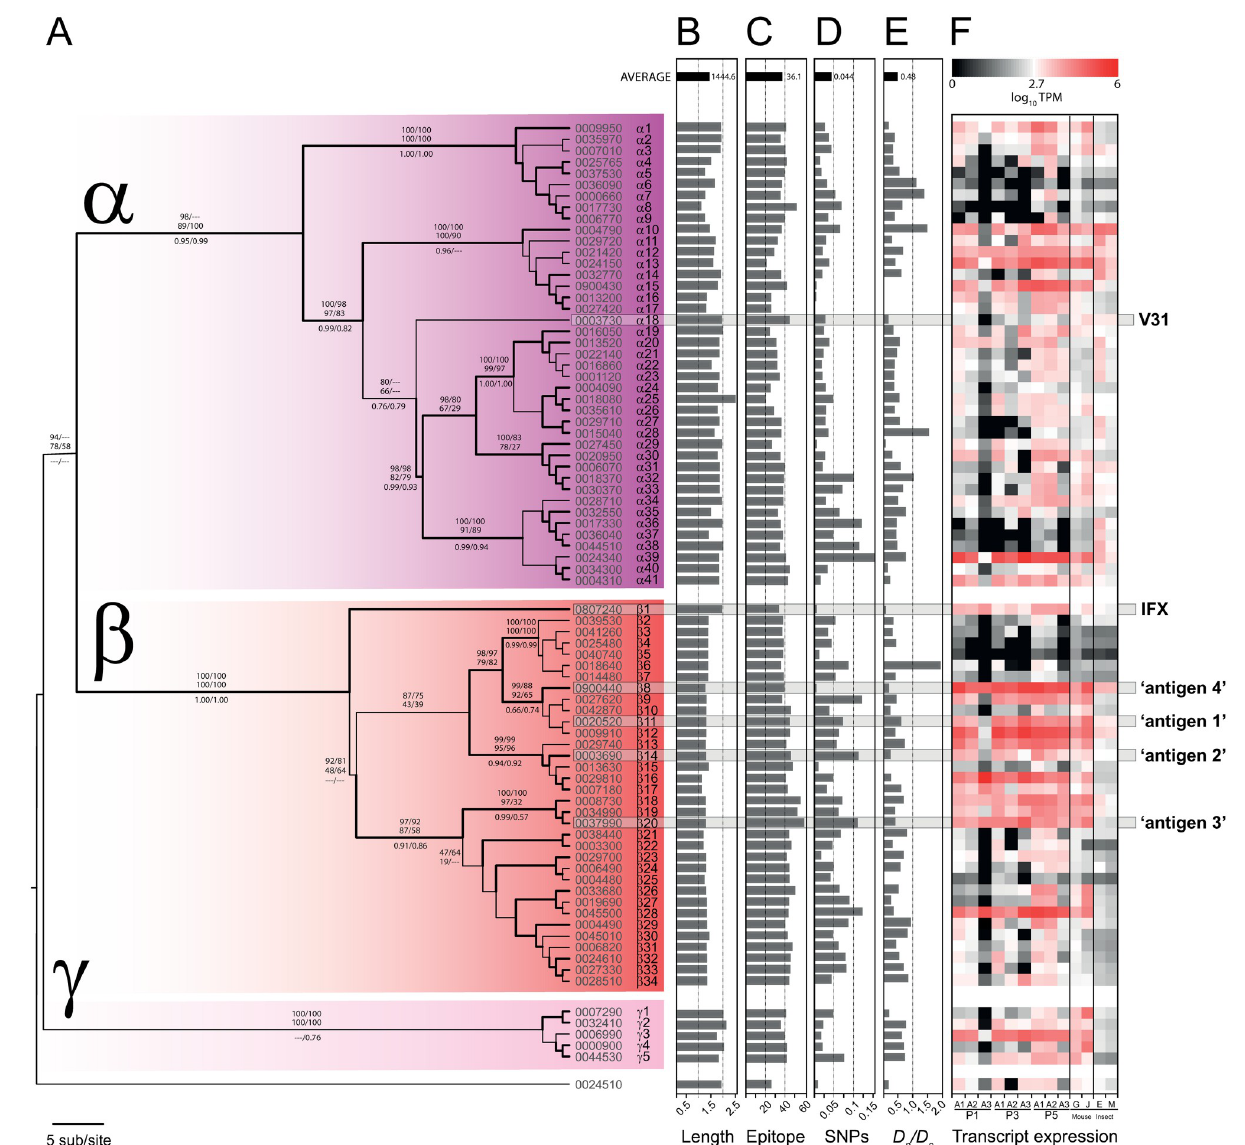
Fig 2. Vivaxin gene family phylogeny and molecular evolution. (A) Maximum likelihood phylogeny of vivaxin genes (n = 81) in the T . vivax Y486 reference genome estimated with a GTR + Γ substitution model ( α = 3.677), and divided into three principal sub-families, labelled α , β and γ . The tree is rooted with a divergent sequence (TvY486_0024510) that approximates to the mid-point. Topological robustness is measured by the approximate log-likelihood ratio (aLRT), and indicated by branch thickness. Thick branches subtend nodes with aLRT values > 0.9. Robustness measures are given for major internal nodes: maximum likelihood bootstrap values ( > 75) for nucleotide/protein alignments (upper, above branches), neighbour-joining bootstrap values ( > 75) for nucleotide/protein alignments (lower, above branches), and Bayesian posterior probabilities ( > 0.5) for nucleotide/protein alignments (below branch). At the left of each terminal node are the existing TritrypDB gene identifier (i.e. TvY486_XXXXXXX) and new gene names; the positions of IFX and V31 antigens [23] and four expressed antigens in this study (1–4) are highlighted within horizontal grey boxes. (B) Gene length mapped to tree topology. (C) Total length of predicted human B-cell epitopes as a proportion of gene length, as inferred by Bepipred linear prediction 2.0 [50]. (D) Single nucleotide polymorphisms (SNP) across a panel of 25 T . vivax strain genomes (as described previously in [48]), as a proportion of gene length. (E) Ratio of non-synonymous to synonymous substitutions ( D n /D s ) inferred from published SNP data [48]. (F) Heat maps showing vivaxin gene expression profiles from published T . vivax transcriptomes [25,48].The first nine columns show relative transcript abundance during an experimental infection in goats. Three peaks in parasitaemia are shown (first, third and fifth respectively; see [48]), with three replicates for each (A1-A3). Columns 10 and 11 show relative transcript abundance in bloodstream-stage infections in mice using different T . vivax strains, LIEM-176 [49] and IL1392 [25], respectively. Columns 12 and 13 show transcript abundance in batch transcriptomes of in vitro cultured T . vivax insect-stages, i.e. epimastigotes (E) and metacyclic-forms (M) respectively [25].